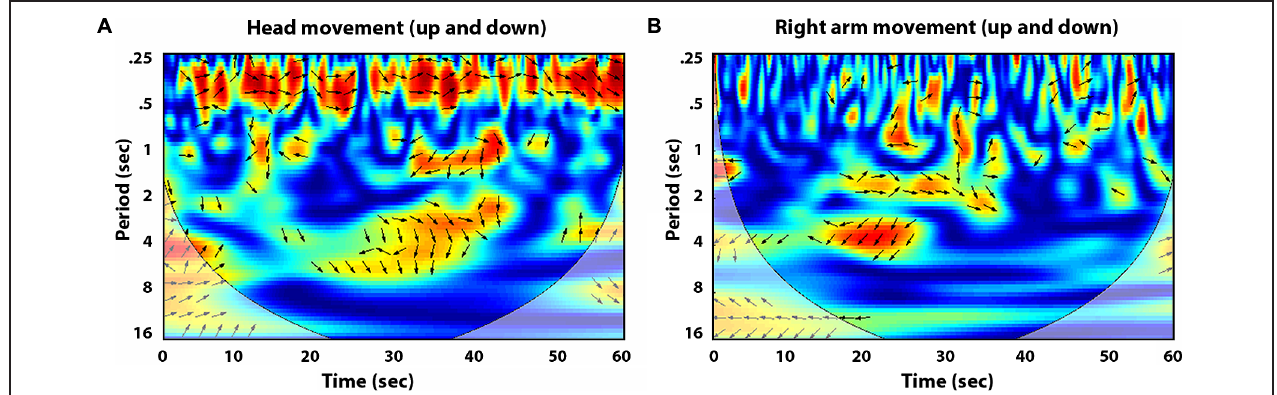
FIGURE 3 | Cross wavelet analysis of experimental data from two piano players improvising with a swing backing track. (A) Displays coordination of the musician’s upward and downward head movements, while (B) displays the coordination of the upward and downward movements of the musicians’ right hands.